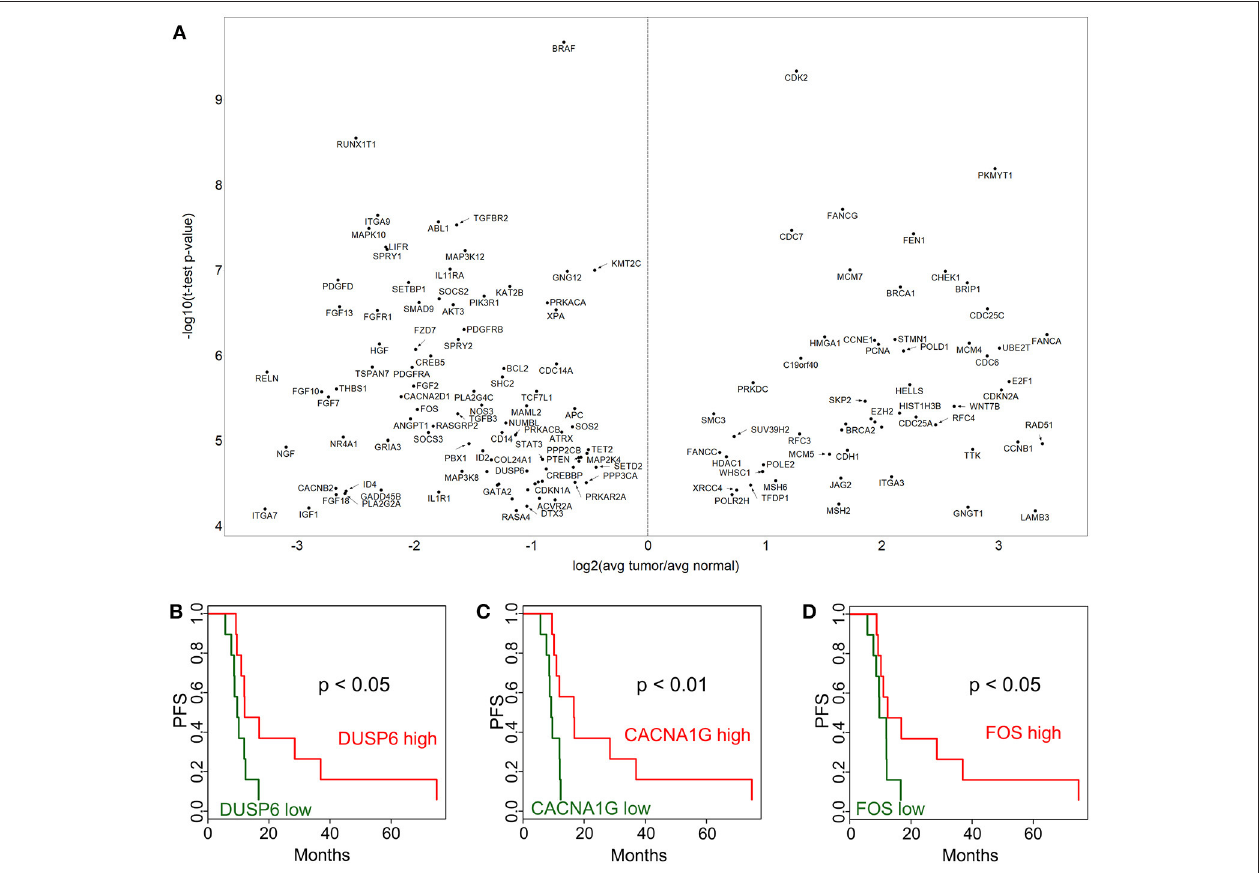
FIGURE 2 | Cancer pathway-associated genes show diverse alterations in cervical cancer. Cervix tumor and adjacent normal tissue expression comparisons are shown in (A) for genes in the NanoString Cancer Pathways code set. Progression-free survival (PFS) associations for selected genes in the NanoString panel, DUSP6 (B) , CACNA1G (C) , and FOS (D) are displayed comparing high (above median) and low (below